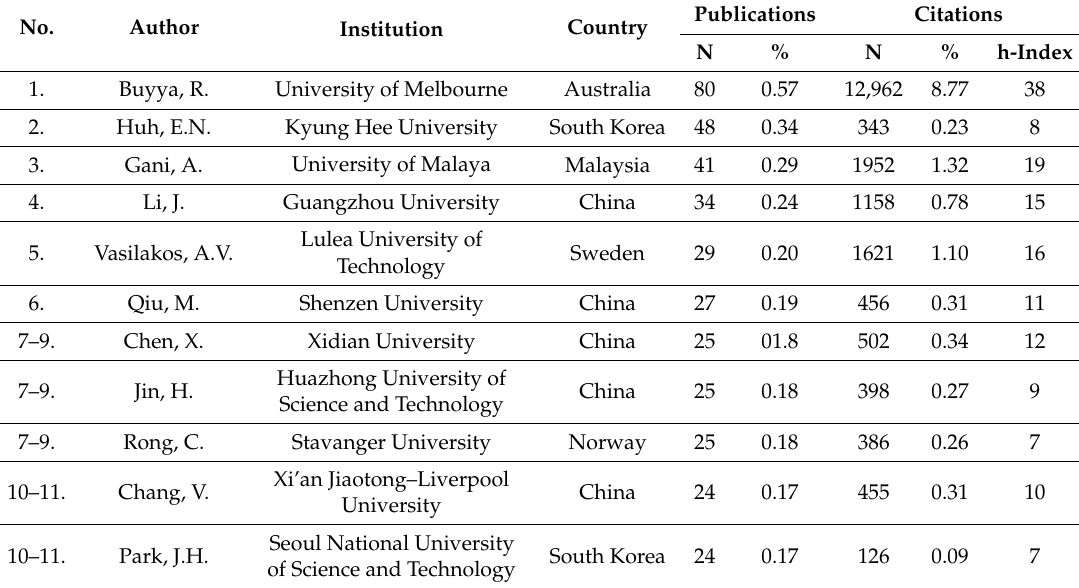
Table 4. Top most productive authors in research on cloud